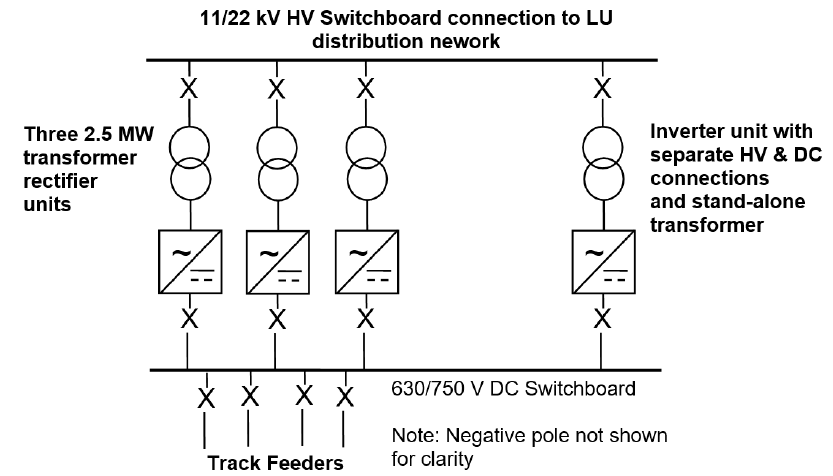
Figure 9. Substation arrangements in upgrading London Underground [48].